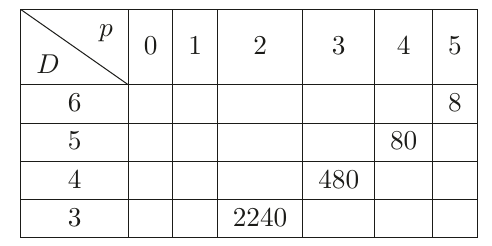
Table 4 . The F 8 , 6 family of branes. These branes always double and there is an extra multiplicity factor